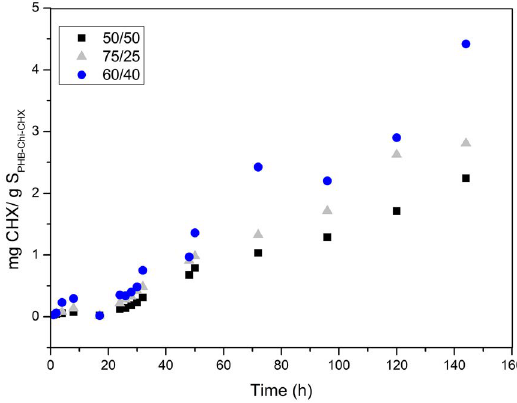
matrices. PHB-Chi-CHX